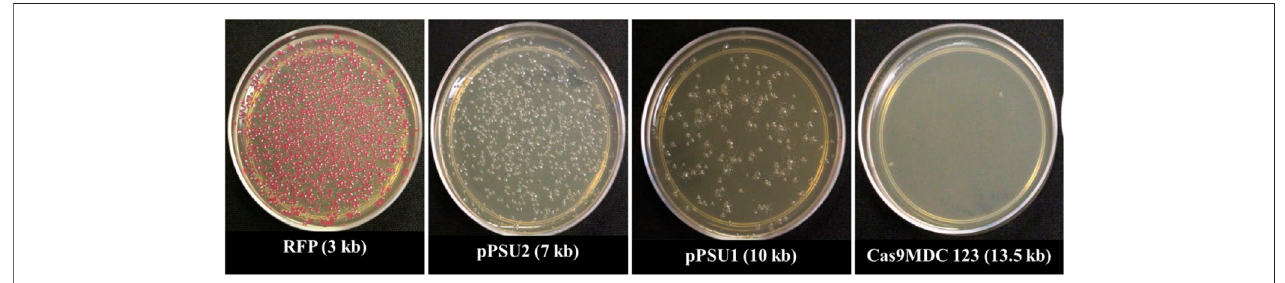
FIGURE 4 | Plasmid delivery by COOH-FCDs of different sizes.